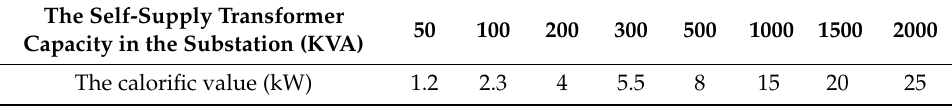
Table 3. Calorific values for transformers in the